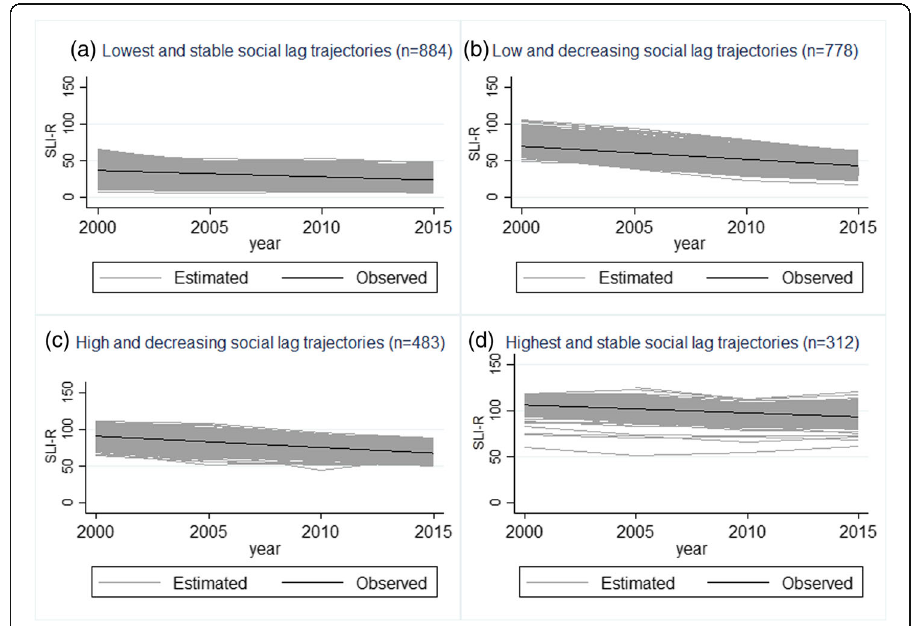
Fig. 3 Four class solution of social lag trajectories. Note: “ lowest and stable ” ( a ), “ low and decreasing ” ( b ), “ high and decreasing ” ( c ), and “ highest and stable ” ( d